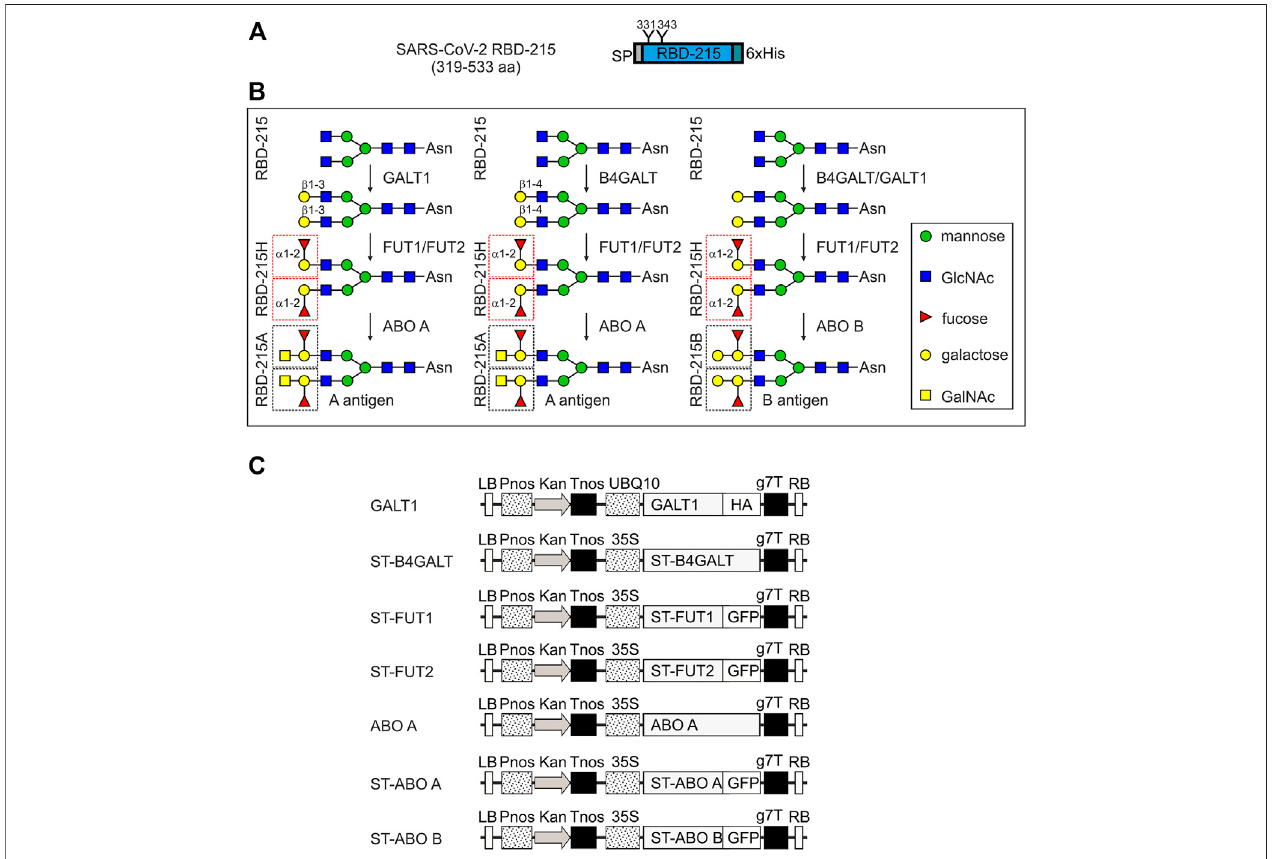
FIGURE 2 | Schematic overview of the glycoengineering strategy and the used expression constructs. (A) Illustration of the plant-expressed RBD (amino acid region 319 – 533 of the SARS-CoV-2 spike protein). (B) Glycoengineering steps to produce different ABH blood group antigens in plants. GALT1: A. thaliana Lewis-type β 1,3-galactosyltransferase 1; B4GALT: human β 1,4-galactosyltransferase; FUT1/FUT2: human α 1,2-fucosyltransferases. ABO A: human α 1,3-GalNAc-transferase; ABO B: human α 1,3-galactosyltransferase. (C) Schematic presentation of the expression cassettes for the different glycosyltransferases. LB: left border; Pnos: nopaline synthase genepromoter; Kan:neomycin phosphotransferaseIIgene;Tnos: nopaline synthasegeneterminator;UBQ10: A. thaliana ubiquitin-10promoter; ST: N-terminal trans -Golgi targeting region from rat α 2,6-sialyltransferase (amino acids 1 – 52); HA: hemagglutinin tag; GFP: green fl uorescent protein; g7T: agrobacterium gene 7 terminator; RB: right